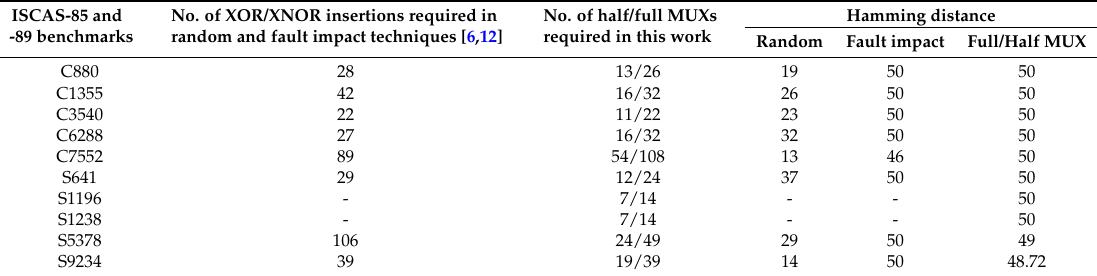
Table 1. The number of MUX insertions based on half and full output numbers with the Hamming distance evaluated and compared with the random and fault impact analysis approaches. ISCAS-85 and -89